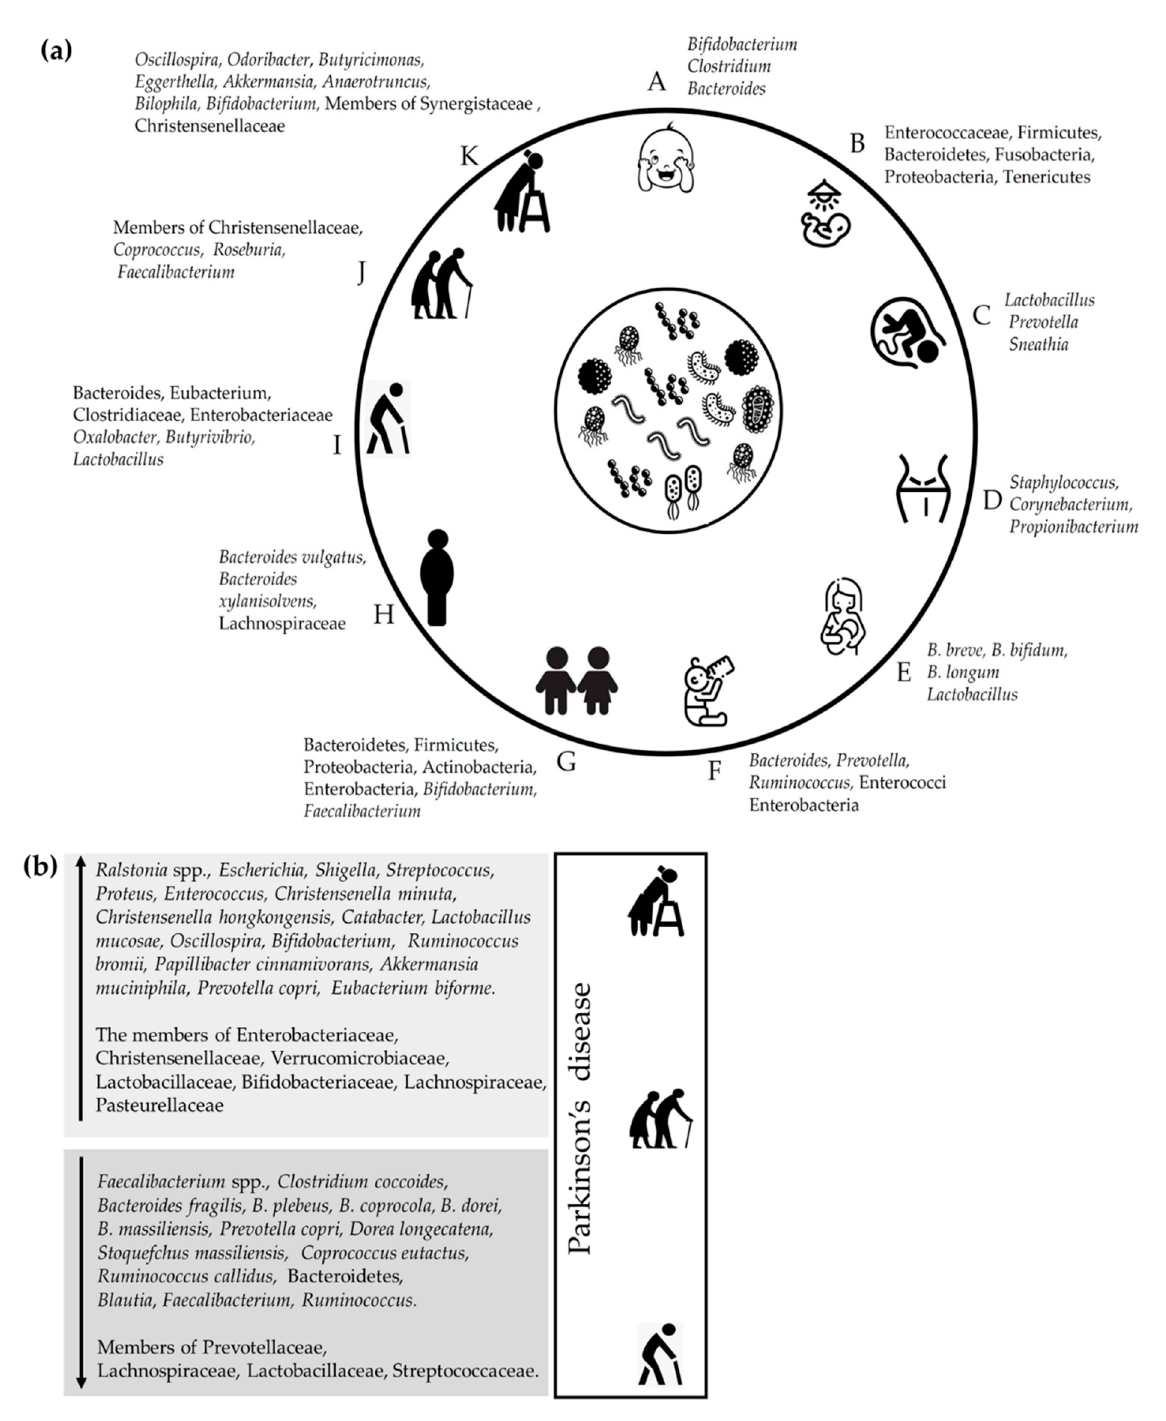
Figure 1. ( a ) Diagrammatic representation of predominant gut microbiome members in humans across ages. A: newborn baby; B: pre-term infants; C: infant from vaginal birth; D: infant from cae-